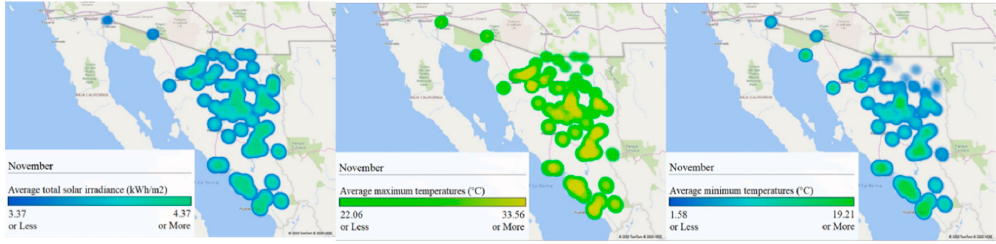
Figure 17. GIS analysis of Sonora for November: ( left ) average total solar irradiance (kWh/m 2 ), ( center ) maximum average temperatures (°C), and ( right ) minimum average temperatures (°C).